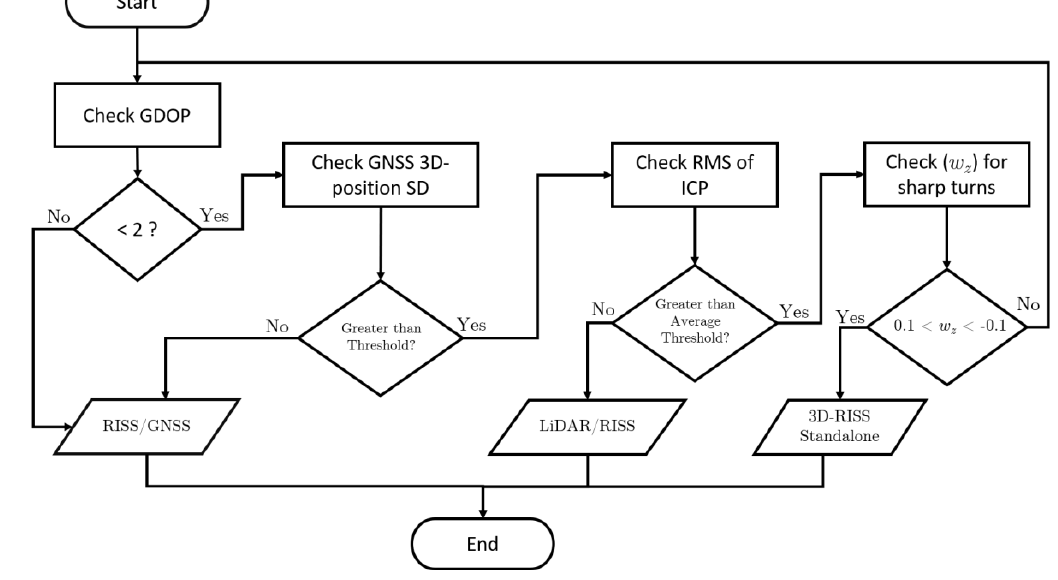
Figure 11. Switching Algorithm Flowchart.